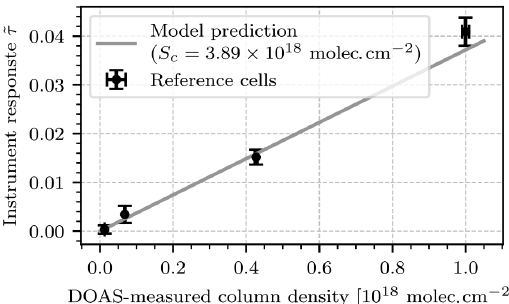
Figure 10. Scatter plot of the instrument response ˜ τ against the DOAS-measured column density of each test cell. The gray line shows the prediction of the instrument model with cell column den- sity S c = 3 . 89 · 10 18 molec.cm − 2